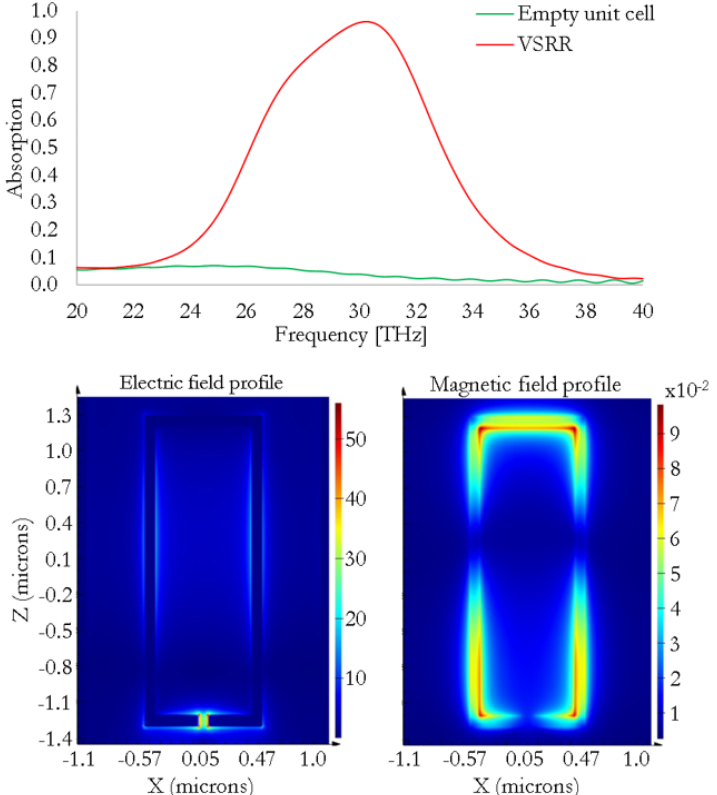
Figure 2. ( top ) Spectral absorption; and ( bottom ) electric and magnetic field profiles (magnitudes) in V/m and A/m, respectively, are shown for a unit cell containing a single vertical split-ring resonator (VSRR).